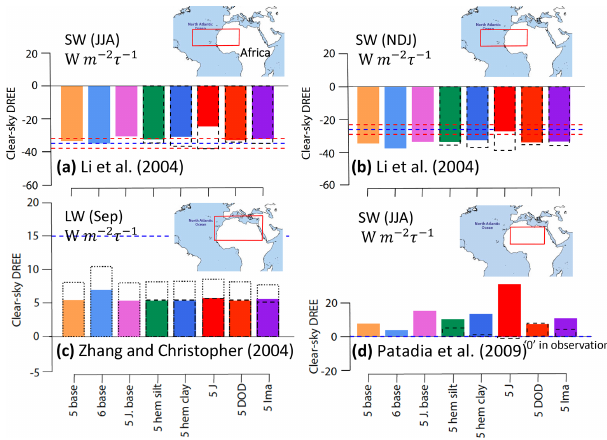
Figure 12. Comparison of clear-sky shortwave (SW) and longwave (LW) dust DRE efficiency (unit: Wm − 2 τ − 1 ) to observation at the TOA. The model–observation comparison is in summer and win- ter over the North Atlantic ( a, b ; JJA and NDJ; Li et al., 2004), September ( c , Sep; Zhang and Christopher, 2003), and summer over northern Africa ( d ; JJA; Patadia et al., 2009) for the longwave and shortwave spectral ranges, respectively. The DRE efficiency is cal- culated as a ratio of DRE under clear-sky conditions to simulated DOD (indicated by τ ). First three bars from the left: DRE efficiency calculated in CAM5 and CAM6 with mean soil data of J2014 and C1999; last five bars: values obtained from runs in CAM5 with high (in color) and low (dash) bounds. Horizonal blue lines denote the observational mean, and two red dash lines in (a) and (b) denote uncertainty in the observations. Note zero SW dust DRE efficiency in the observations over northern Africa in summer (d) (Patadia et al., 2009). Inlet maps with the red box show the location where ob- servational DRE efficiency is made and used for comparison. x -axis labels: 5 base – CAM5 with C1999; 6 base – CAM6 with C1999; 5 J. base – CAM5 with J2014; 5 DOD – CAM5 DOD; 5 Ima – CAM5 imaginary complex refractive index. Dot boxes in (c) indicate long- wave DRE augmented by 51%.